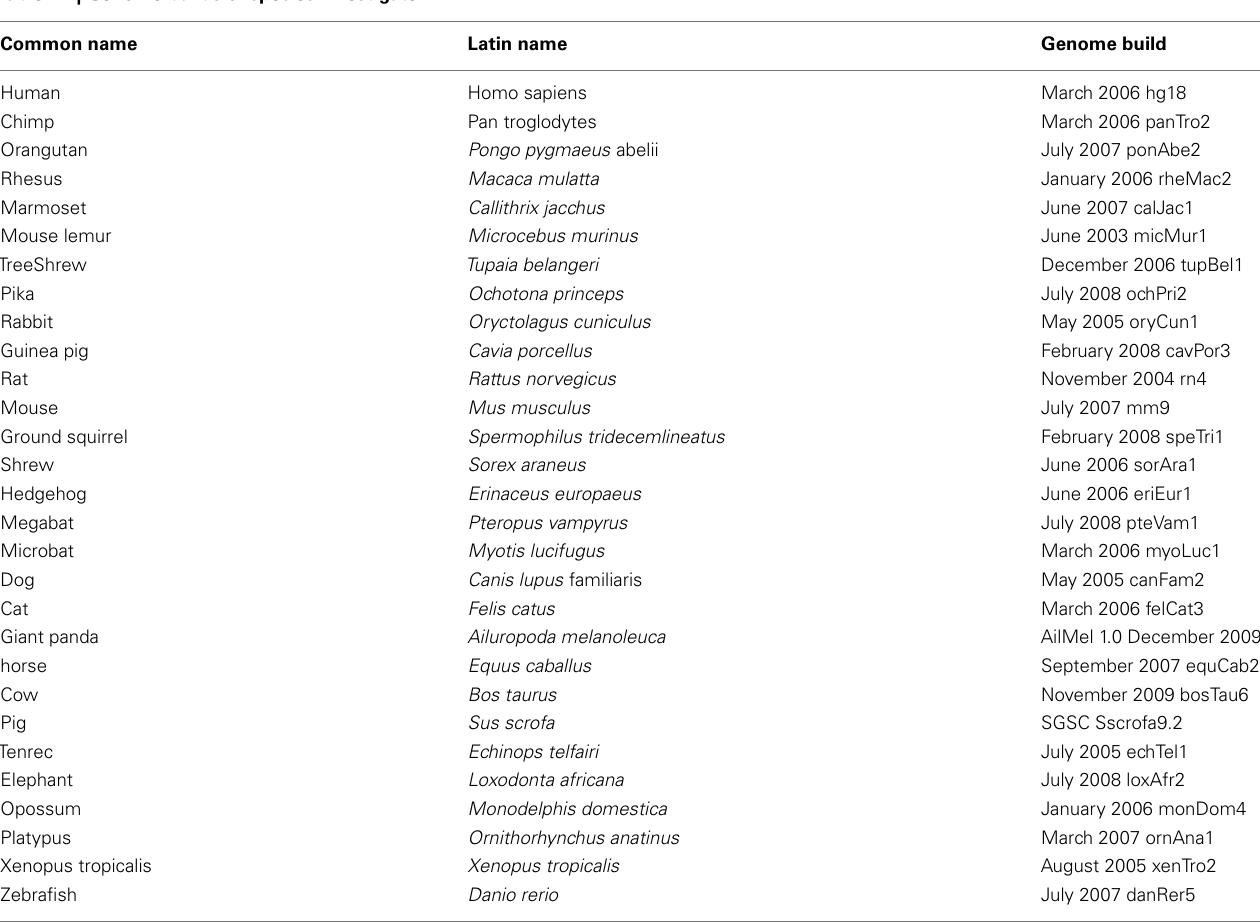
TableA1 | Genome builds of species